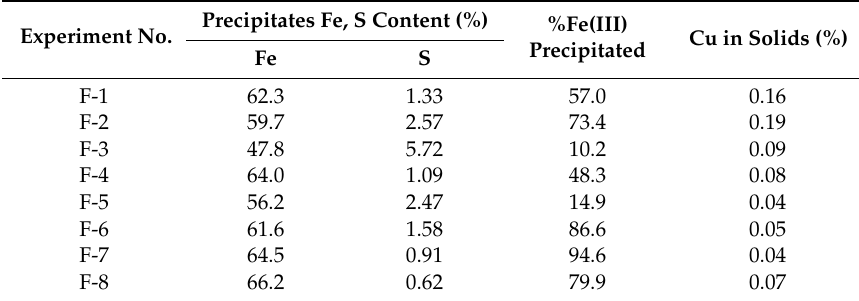
Table 5. Elemental analysis of the fractional factorial design